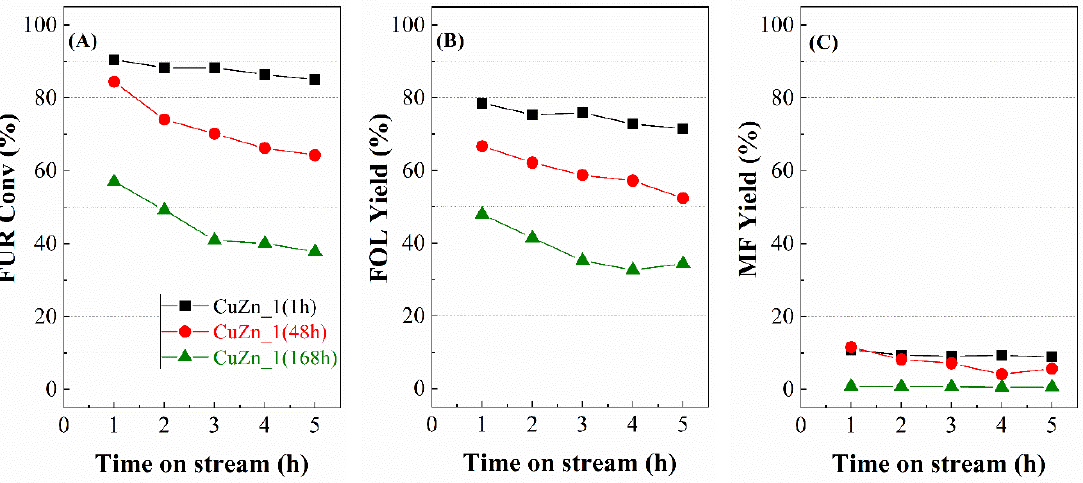
Figure 12. FUR conversion ( A ), FOL yield ( B ), and MF yield ( C ) in the FUR hydrogenation over CuZn_1 catalysts synthesized with different aging time (1–168 h) (Experimental conditions: Mass of catalyst = 0.15 g, Pressure = 0.1 MPa, H 2 flow = 10 mL min −1 , Fed flow = 2.3 mmol FUR h −1 ).